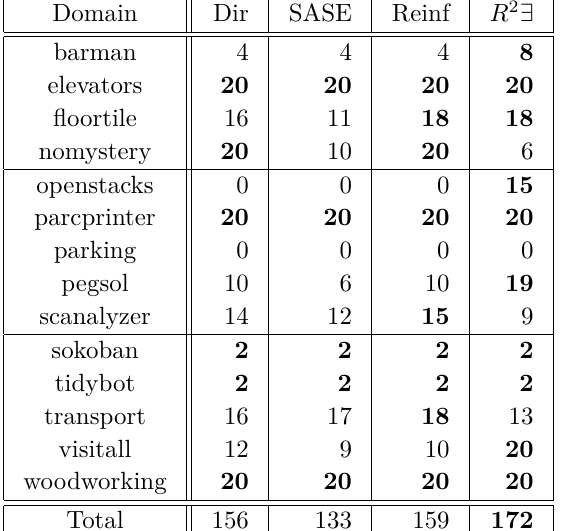
The sum of makespans of the plans found within the time limit for each domain. Lower makespan means fewer SAT solver calls, it does not indicate better plan quality. Domains with the same number of solved problems for each encoding are high-